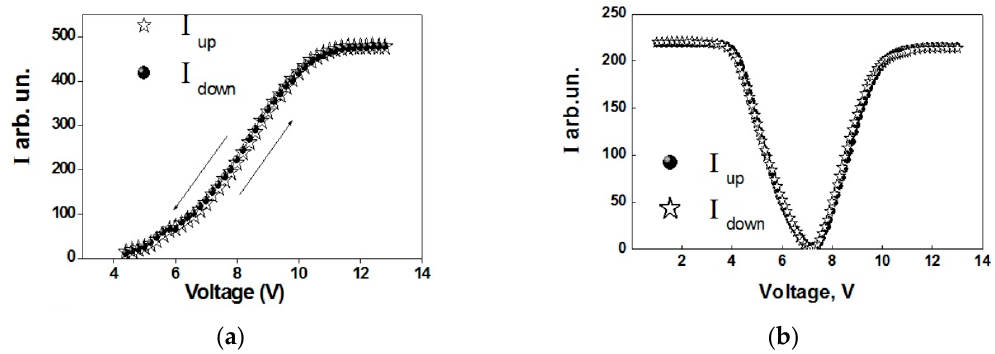
Figure 9. S-shaped ( a ) and V-shape ( b ) FLC multi-stable switching [29].